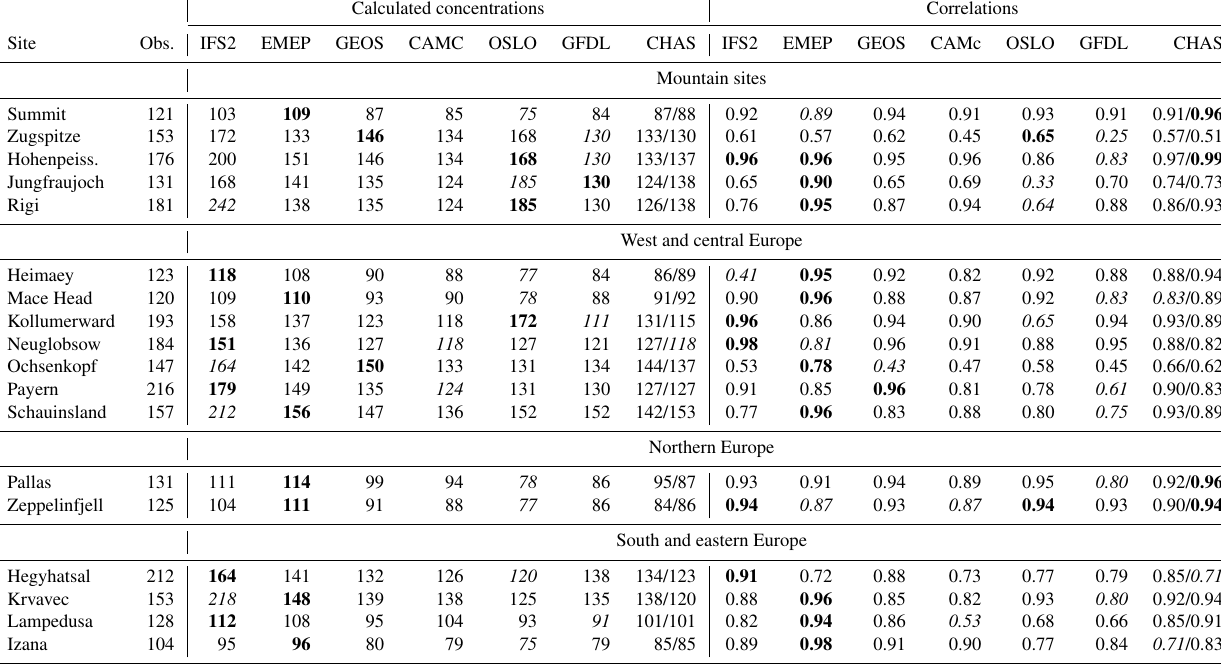
Table 1. Annual mean measured and model-calculated CO in ppb for the European CO GAW sites downloaded from http://ds.data.jma. go.jp/gmd/wdcgg/ (last access: 21 September 2018). See also Supplement for figures. The comparison is based on monthly average model and measured data. Model IFS2 is IFS_v2, EMEP is EMEP_rv48, GEOS is GEOS-Chem, CAMC is CAMchem, OSLO is OsloCTM3_v2, GFDL is GFDL_AM3 and CHAS are the CHASER models (CHASER_t106/CHASER_re1). Bold face (italic) numbers represent the model- calculated concentration with highest (lowest) model biases and correlations at the individual sites. Obs. is the observation. Calculated concentrations